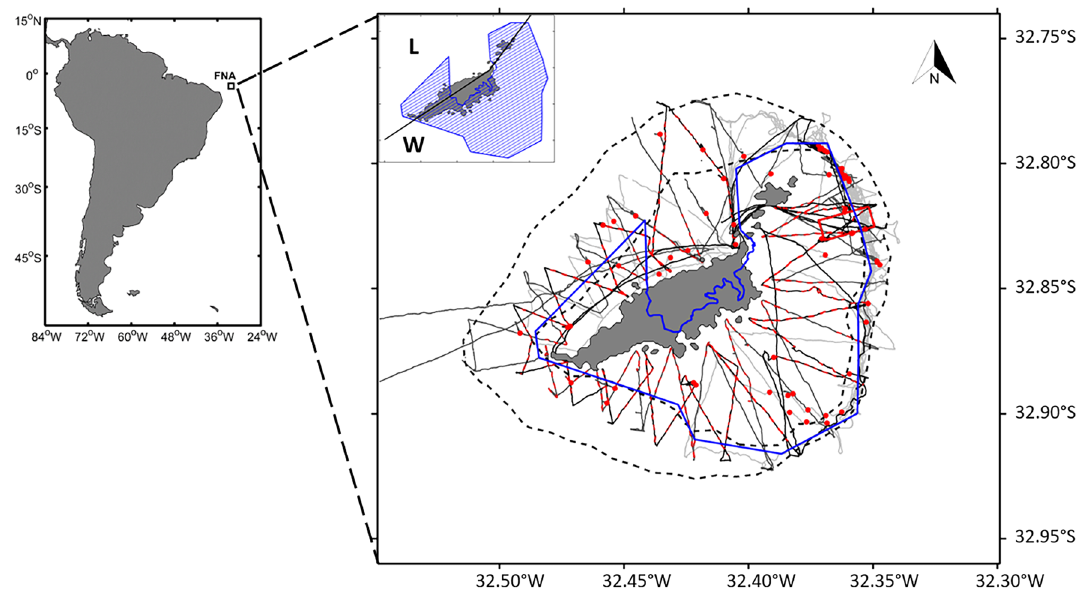
Figure 1. Fernando de Noronha archipelago (FNA) (03°51 ′ S, 32°25 ′ W). The blue line delimits the no take MPA PARNAMAR. Acoustic transects are depicted by light grey (FAROFA 1), dark grey (FAROFA 2) and black lines (FAROFA 3); video transects by red dashed lines and video stations by red dots. The black dashed lines depict the 50 and 300 m isobaths. The insert on the main map show the PARNAMAR hatched in blue and the black solid line separates the leeward side (L) and the windward side (W). Map was created by the authors using Matlab R2018b (https:// fr. mathw orks. com/) and m_map mapping package 84